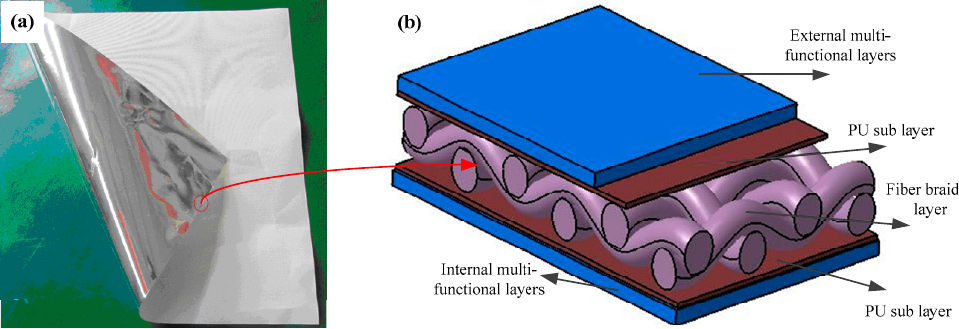
Figure 2. ( a ) Photograph of envelope; ( b ) cross-section of the aerostat envelope [12].